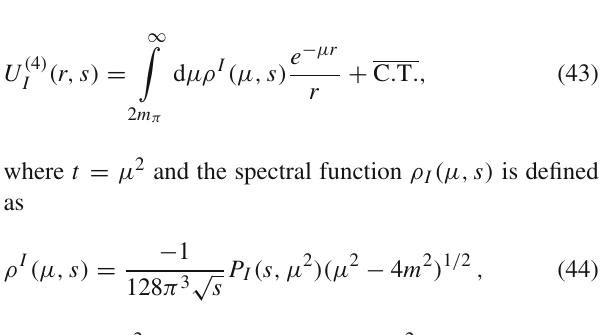
Fig. 1 Chiral 2 π exchange potentials V IJ at threshold a function of the distance for I J = 00 (dashed), I J = 11 (full)